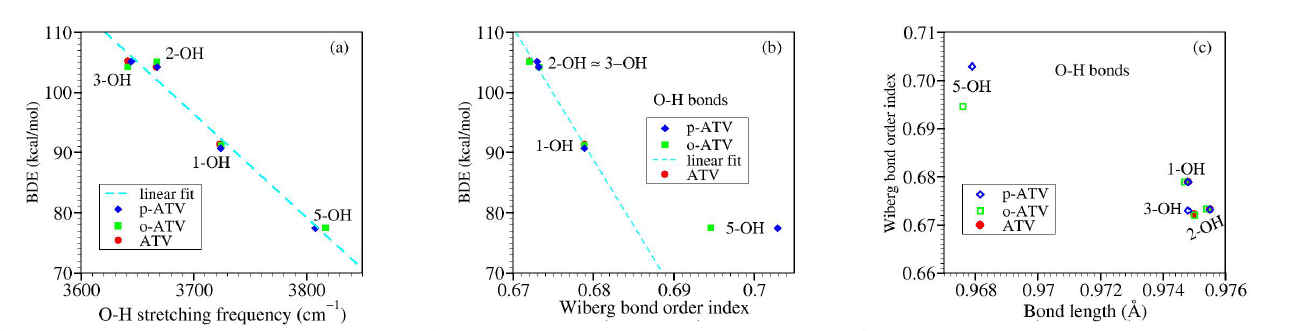
Figure 9. Results for OH groups of atorvastatin (ATV) and its metabolites o-ATV and p-ATV: ( a ) bond dissociation energies versus O-H stretching frequencies; ( b ) bond dissociation energies versus Wiberg bond order indices; ( c ) Wiberg bond order indices versus bond